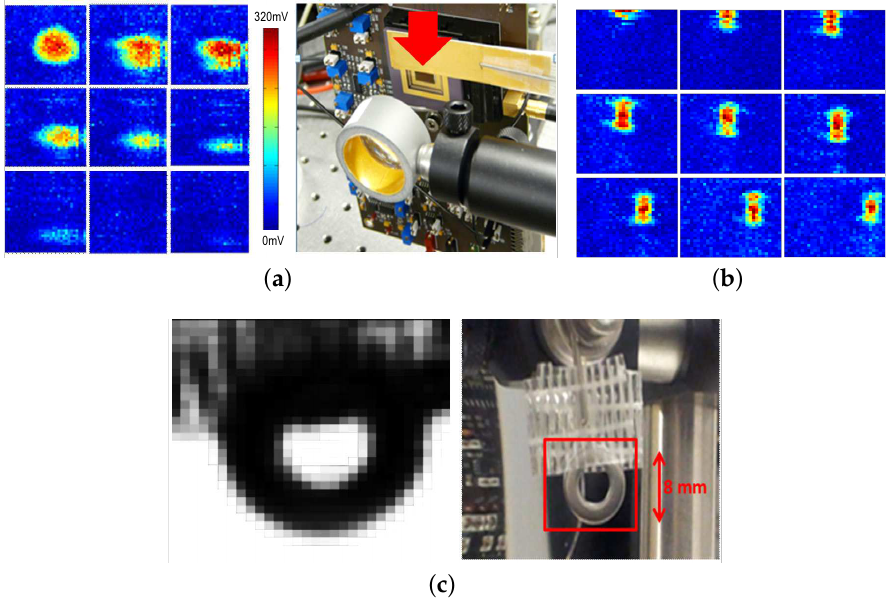
Figure 14. ( a ) Video sequence, obtained at 100 fps, of a copper ruler passing in front of a 200-GHz beam of 2 mW measured at the imager position and modulated at 156 kHz; ( b ) video sequence, obtained at 100 fps, when translating vertically then horizontally the imager exposed to a 270-GHz source with a rectangular waveguide; the THz source is modulated at 156 kHz and delivers 0.5 mW at the sensor position; ( c ) image of a metallic ring held with tape obtained with 2.5 THz using the setup of Figure 12, the antenna and FET detector of one pixel and a lock-in amplifier. Table 1. Overview of the presented THz imager performance compared to recently reported CMOS THz